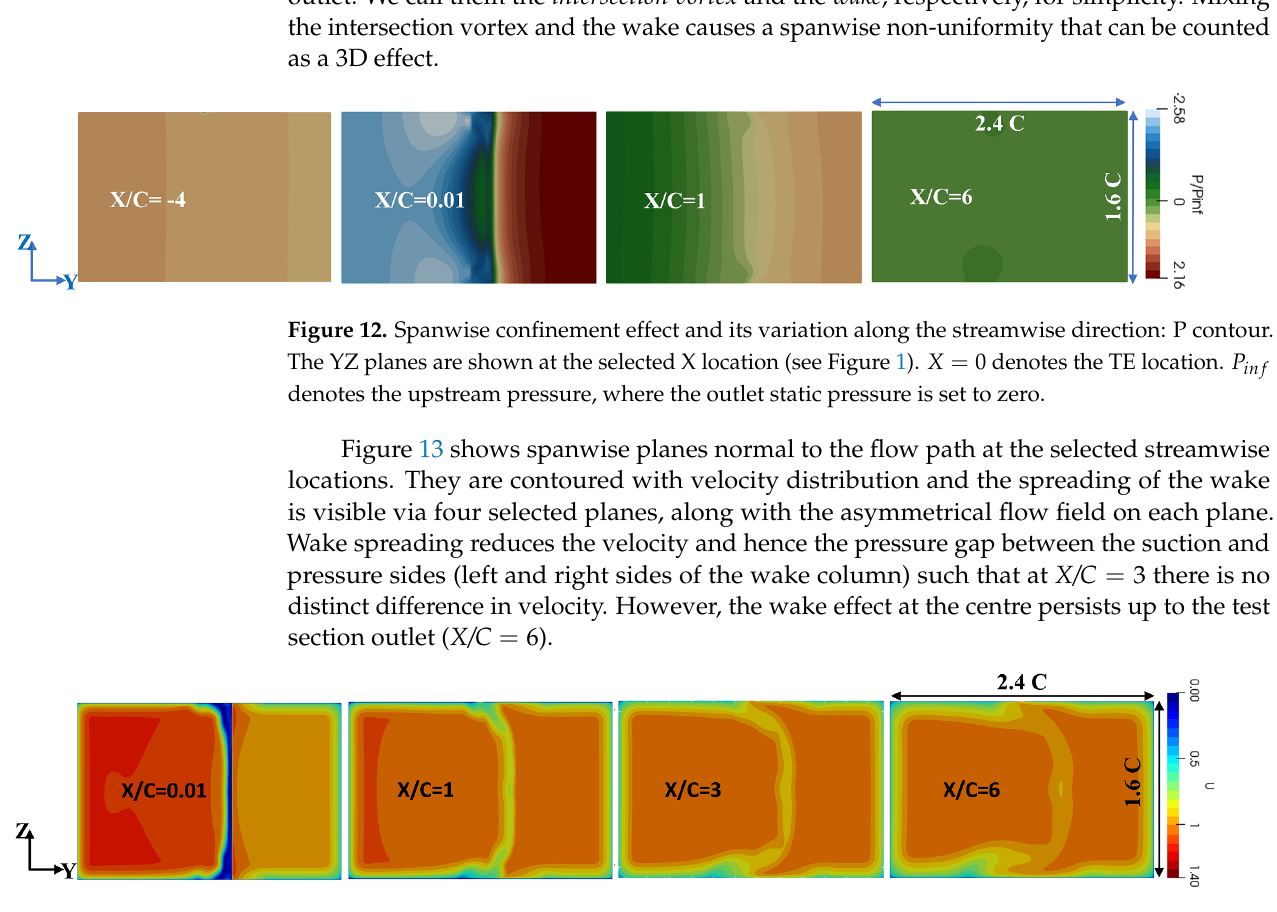
Figure 13. Wake diffusion along the streamwise direction, plus the spanwise confinement effect with respect to the velocity contour. The YZ planes are shown at the selected X locations, see Figure